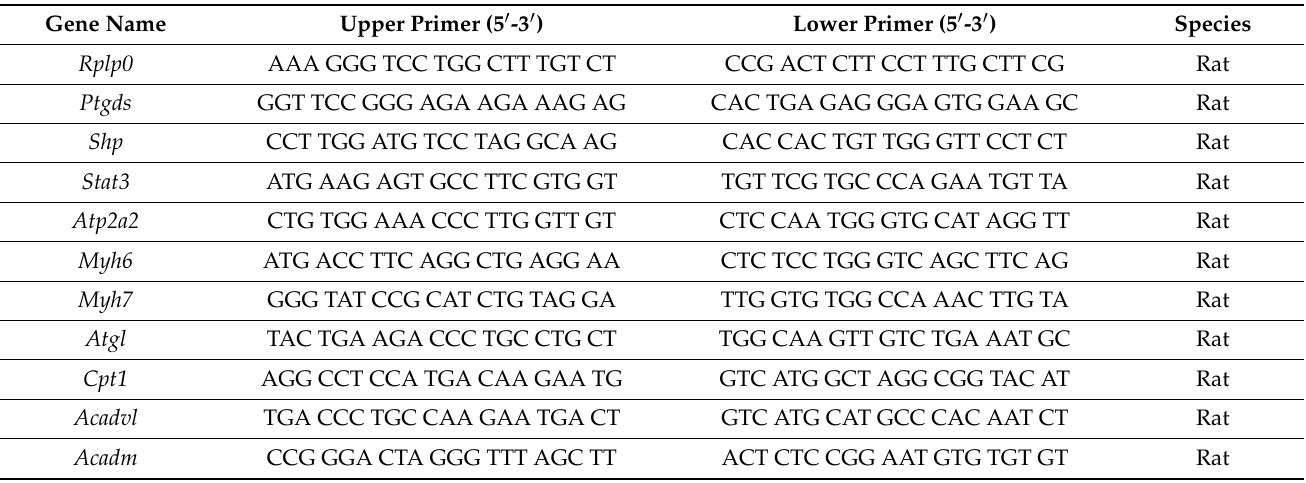
Table 2. Primers used for real-time